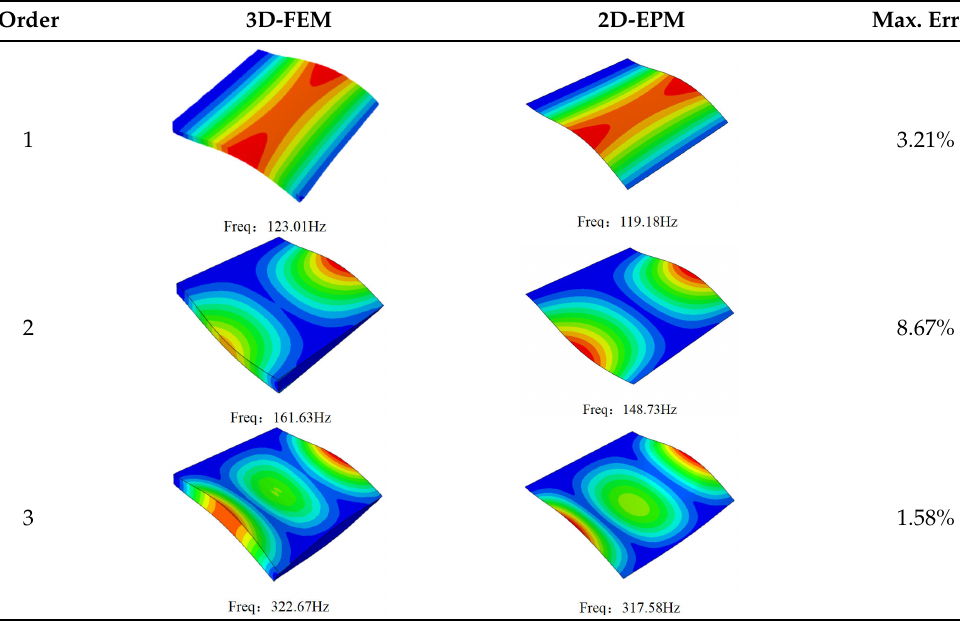
Table 11. Comparison of the first four free vibration characteristics predicted by two models under the boundary condition in Case